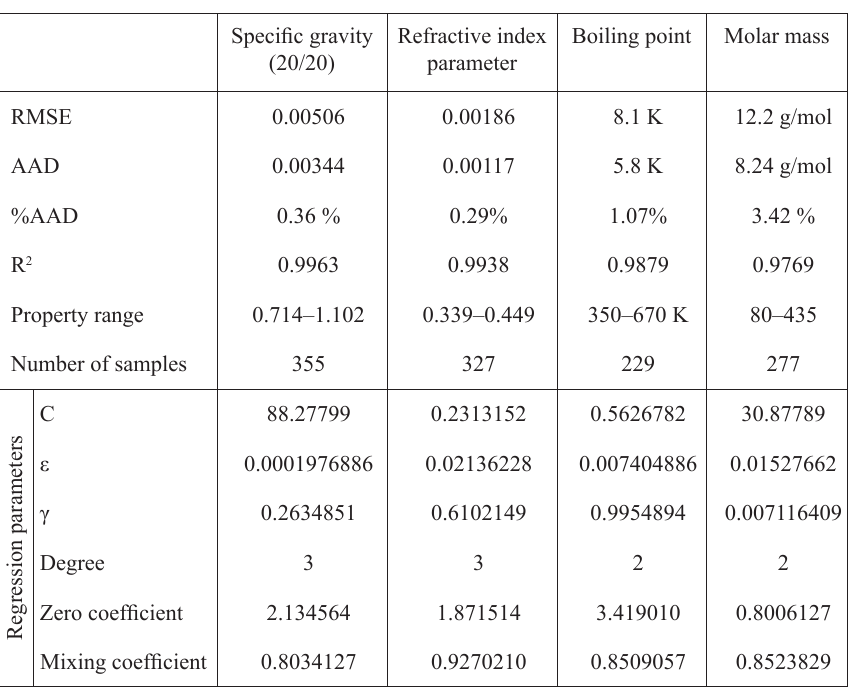
Table 2. Errors and model parameters for each of the multivariate models created based on infrared